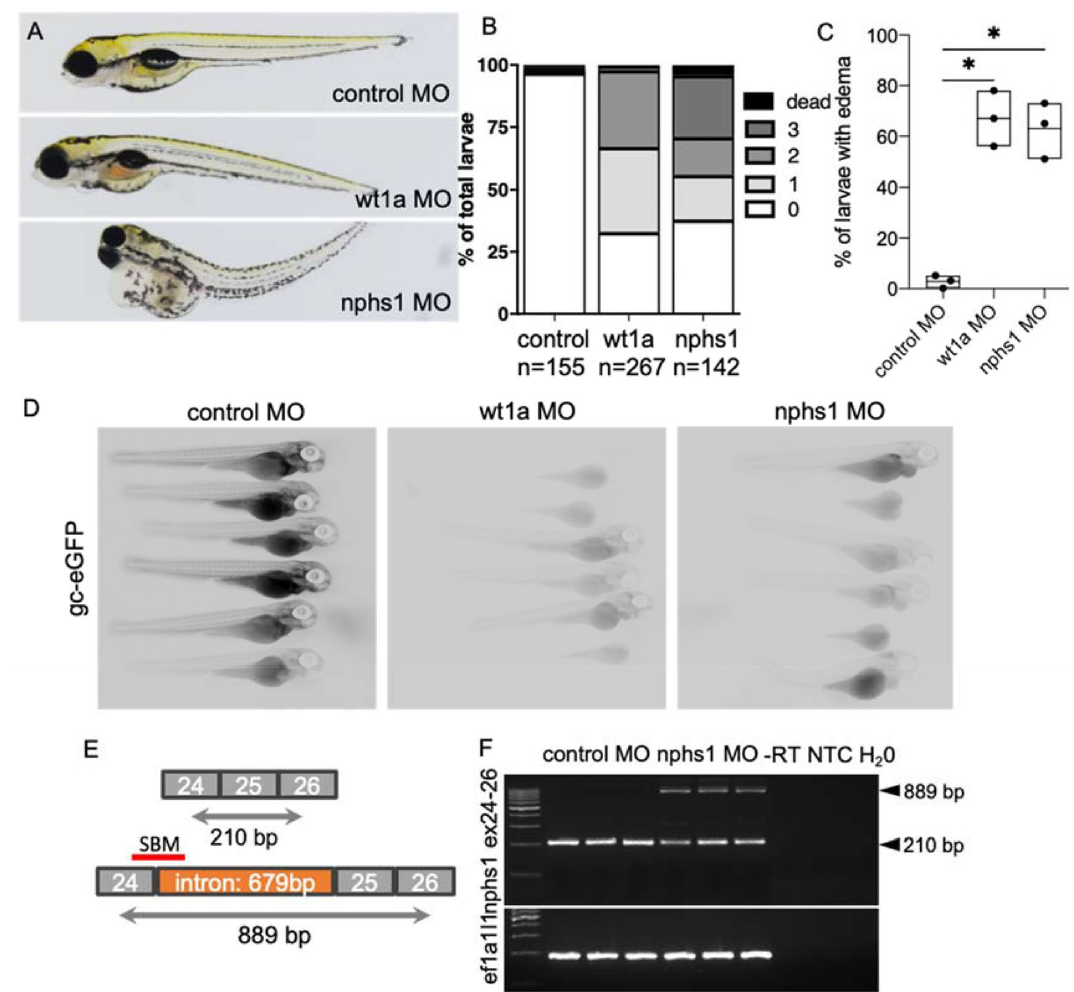
Figure 1. Induction of primary glomerular disease in larval zebrafish: Zebrafish embryos were injected with 2 nl 100 µM translation-blocking anti wt1a, splice-blocking anti-nphs1 or non-binding control MOs. ( A ) Total of n = 564 zebrafish embryos were injected and phenotyped at 120 hpf. Phenotype distribution graded in 0:no edema to 3: severe edema with bent body axis and dead larvae. As shown in the stacked boxplots in ( B ), the phenotype of the wt1a knockdown larvae was generally more severe compared to nphs1 knockdown while the general proportion of larvae with edema was similar in both groups ( C ). No overt edema was seen in control MO injected larvae and the percentage of larvae with edema of any kind was statistically significant higher compared to paired control groups (paired t-test, p = 0.01). Shown in panel ( D ) are the results of the zebrafish proteinuria assay. While control MO-injected Tg(fabp10a:gc-eGFP) larvae showed intravascular localization of gc-eGFP, wt1a and nphs1 MO-injected larvae showed significantly less eGFP-fluorescence indicating clearance of the 78 kDa fusion protein from the blood plasma. ( E ) shows the exon–intron structure of exons 24–26 in the nphs1 gene with respective PCR-primer sites and the SBM MO binding site. Binding of the nphs1 SBM should lead to integration of a 679 bp intron. ( F ) shows agarose gel-resolved RT-PCR products for the nphs1 region described in ( D ) for three independent control and nphs1 SBM injected groups. Arrowheads show the size of the respective wildtype-bands at 210 and the shifted PCR product after intronic